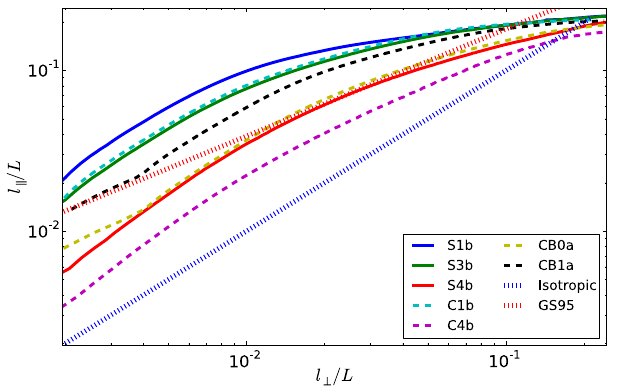
FIG. 8. The variation of l k versus l ⊥ for the Alfv´en-mode magnetic field for the different simulations. The Goldreich- Sridhar scaling is l k ∼ l 2 = 3 ⊥ , shown by the red dotted line (GS). Isotropic behavior l k ¼ l ⊥ is shown by the blue dotted